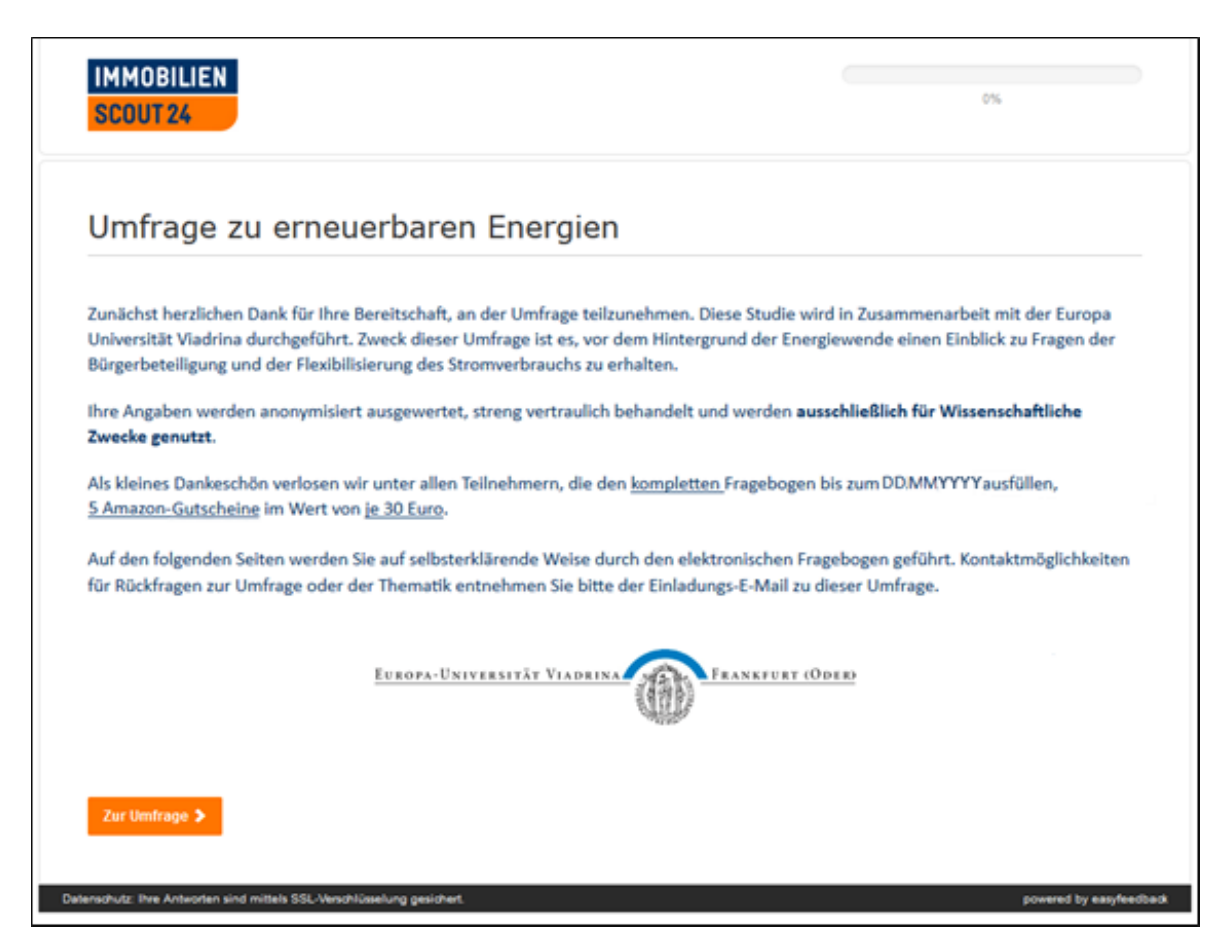
Figure A2. Screenshot of Questionnaire Page 1.